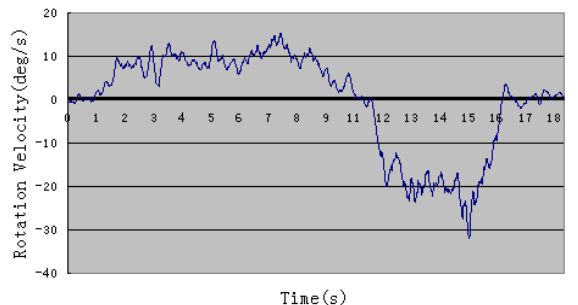
Figure 5. Rotation velocity after